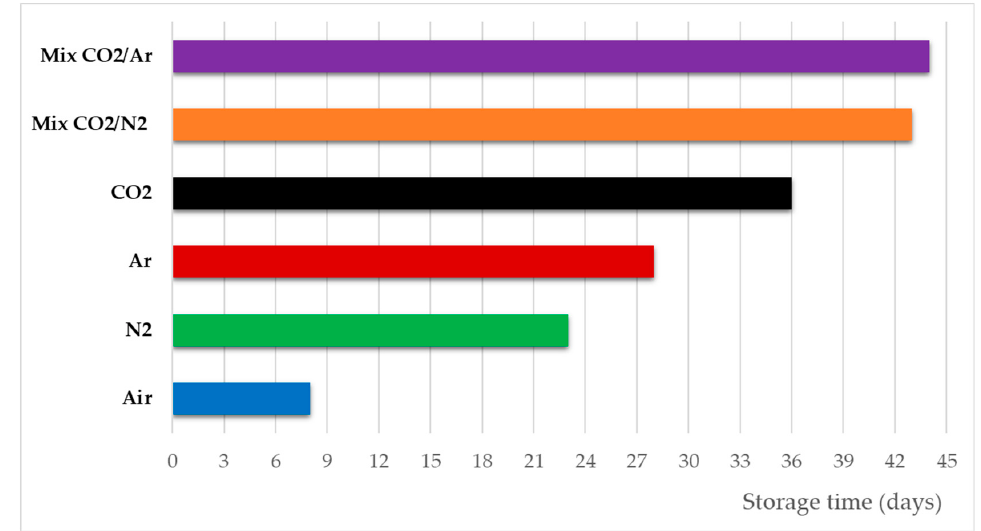
Figure 4. Period of time (days from packaging) during storage before the appearance of fungal bod ‐ ies on 5% of bread samples, for each experimental condition. on 5% of bread samples, for each experimental